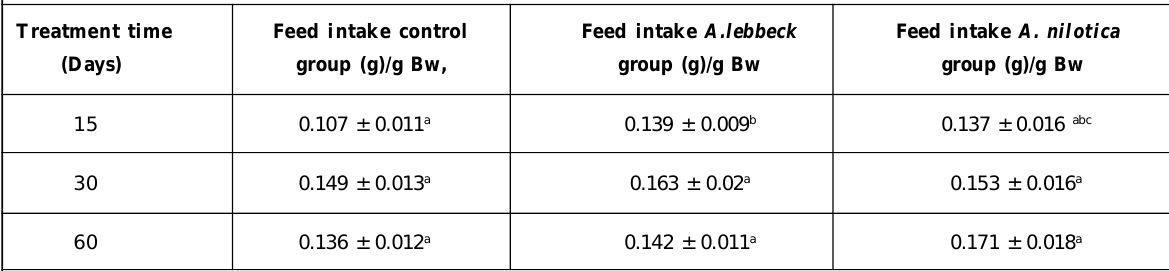
Table 2: Recorded intake of the plain feed and the A. lebbeck and A. nilotica extracts incorporated feed by the male Maltimammate rats ( M. natalensis